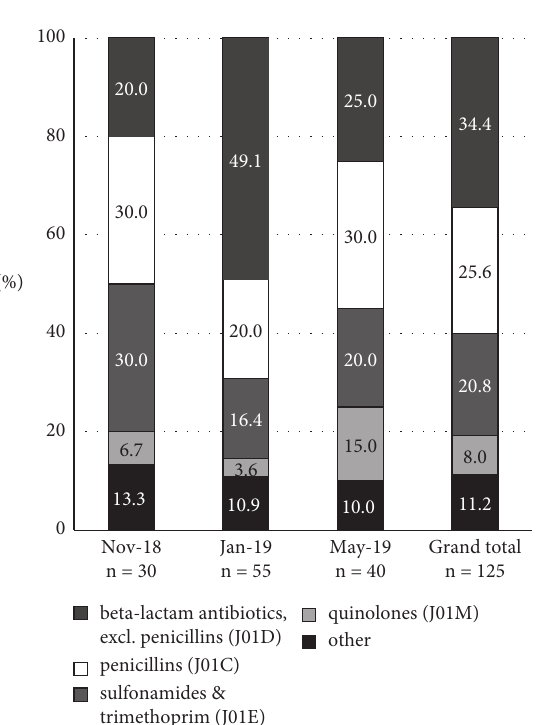
Figure 1: Most prescribed antibiotic (J01) groups according to the WHO/ATCC (level 3) at the Maruki Memorial Welfare and Medical Center, Japan.